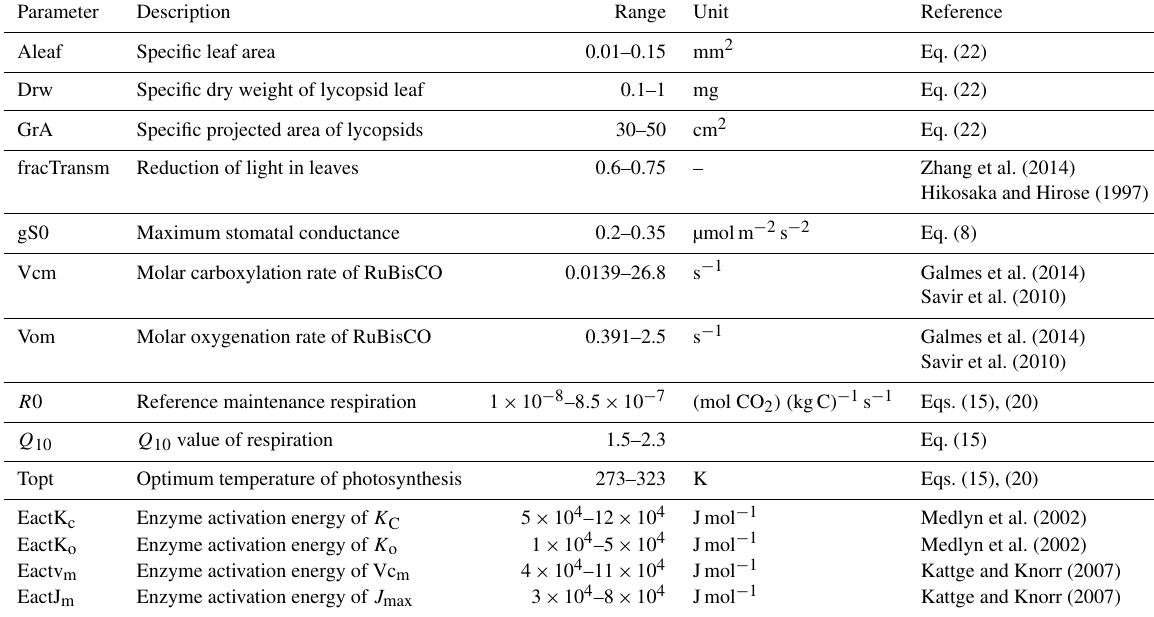
Table 1. Parameters used to define the lycopsid-specific model.